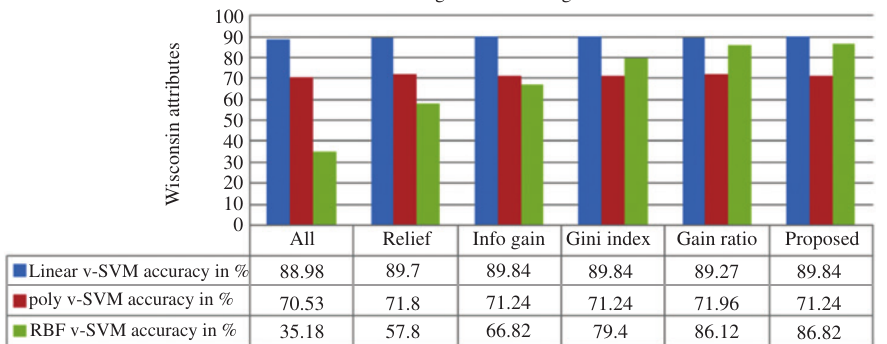
Figure 4: Validating the Performance of WBCD Feature Subset.